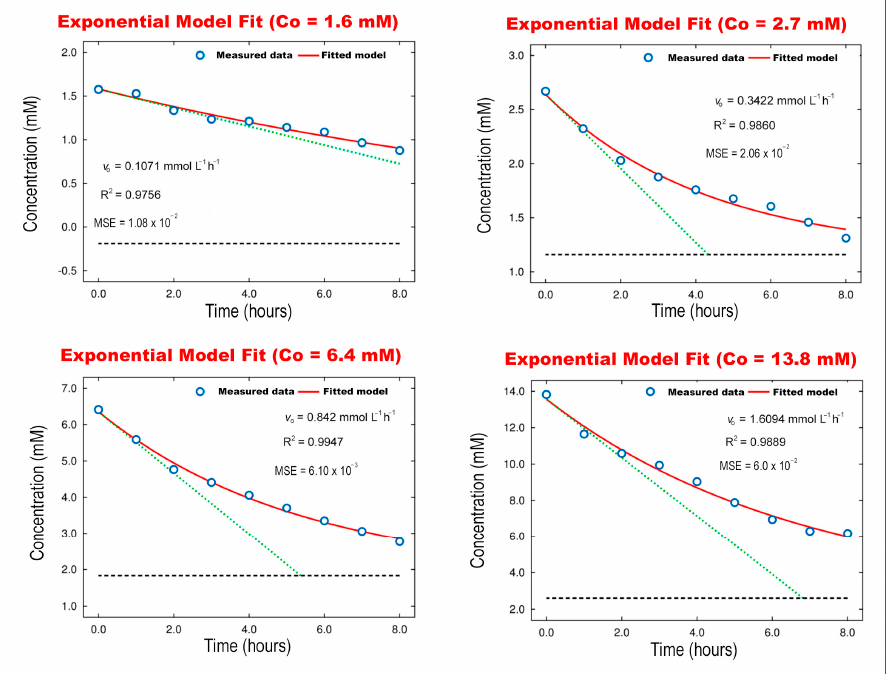
Figure 7. Initial ammonia removal rates by photocatalytic process at different initial concentrations